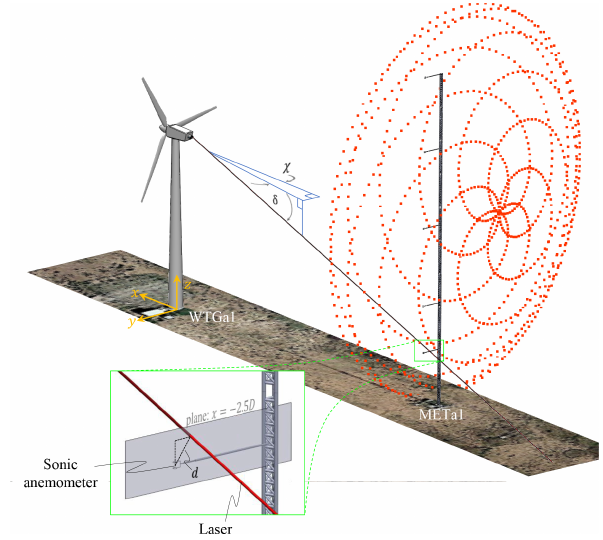
Figure 3. Rendering of WTGa1 and METa1, with the former yawed to 347 ◦ (i.e., nearly 180 ◦ from the orientation shown in Fig. 2) to cover the latter with the lidar scan pattern. Guy wires have been re- moved for clarity. The value χ is the horizontal directional offset angle of the lidar beam from the − x axis, and δ is the elevation angle of the beam, which becomes − 18 . 2, − 11 . 6, 0.2, 11.7, and 22.0 ◦ when the beam is pointed at the center of the five respective anemometers at z = 10 . 1, 18.3, 31.9, 45.4, and 58.3m. The maxi- mum distance, d , in the x = − 2 . 5 D plane between the lidar beam and the center of the sonic anemometer probe for the considered data is 2m. Note that the lidar beam is thickened for clarity; the ac- tual beam diameter at the waist is 2.7mm for the 2.5 D focus